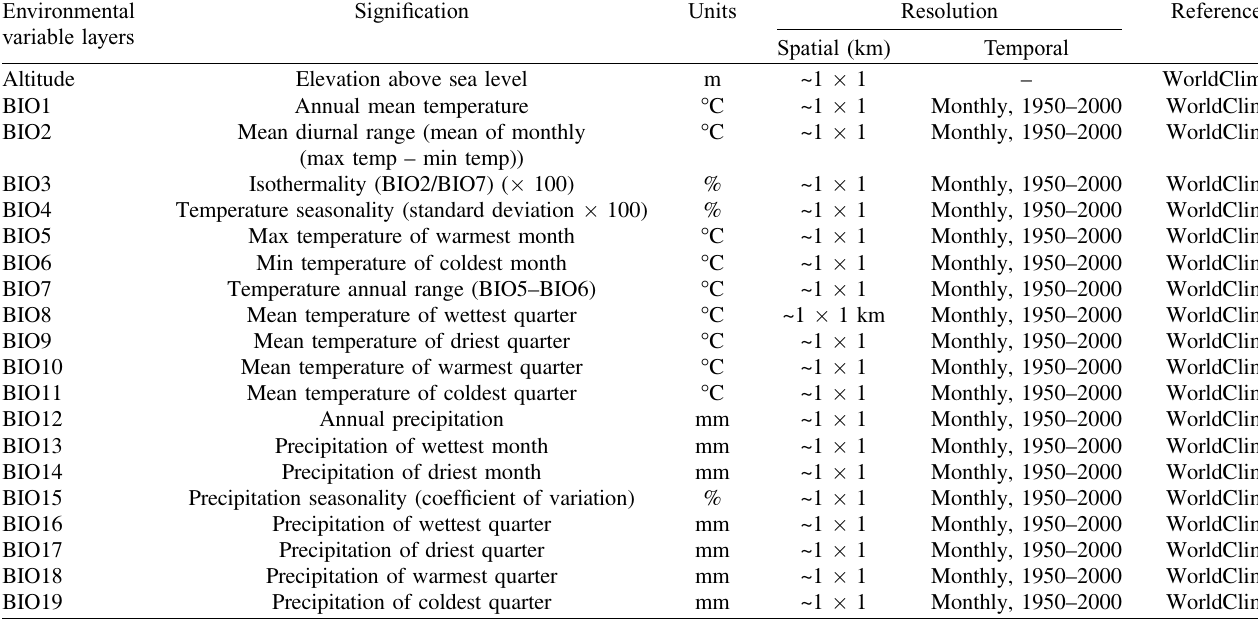
Table 2. Summary of the environmental variables downloaded.